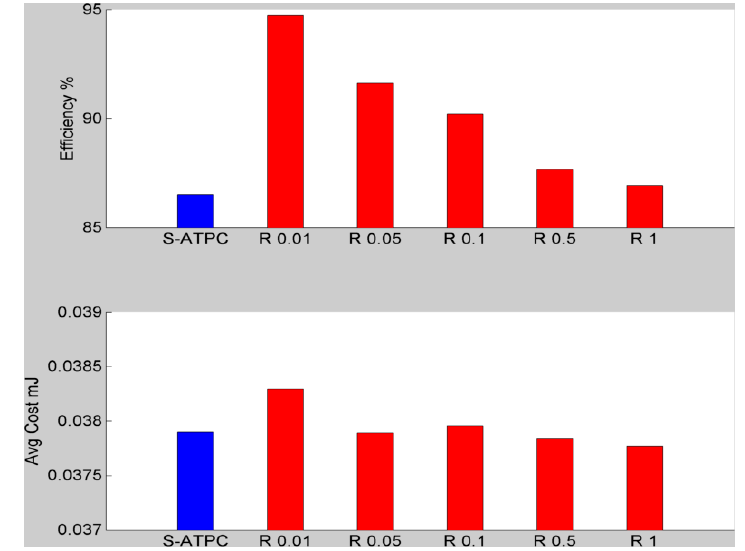
Figure 5. Activity level: Uncertain—the protocol efficiencies and the average cost of success transmissions are compared when the PSR for all the cases are equal to 99%.